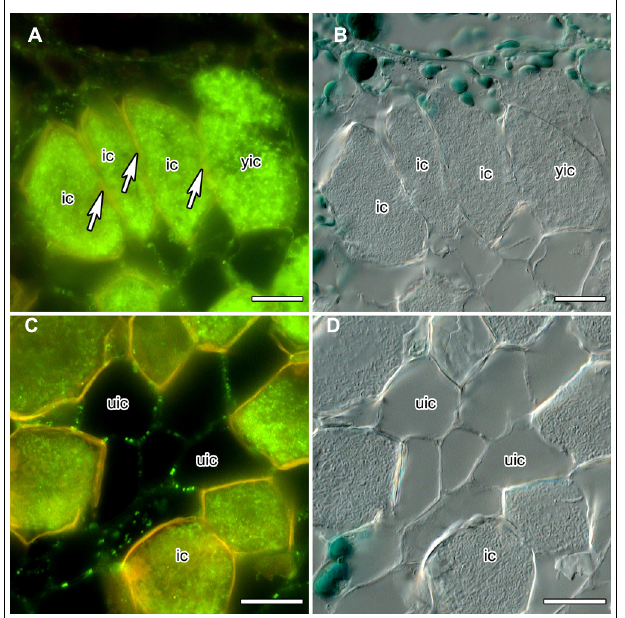
FIGURE 1 | Immunolocalization of calreticulin (CRT) in longitudinal sections of C. glauca nodules embedded in Steedman’s wax (for the method, see Zdyb etal.,2011; for the antibody, see Baluška etal.,1999). Fluorescence micrographs (A,C) and differential interference contrast micrographs (B,D) are shown.The lignified walls of infected cells fluoresce in yellow under blue light. (A,B) No CRT labeling is found in walls (see arrow) between infected cells (ic). (C,D) CRT is labeled in walls connecting uninfected cells (uic) in a punctate pattern. Size bars denote 20 μ